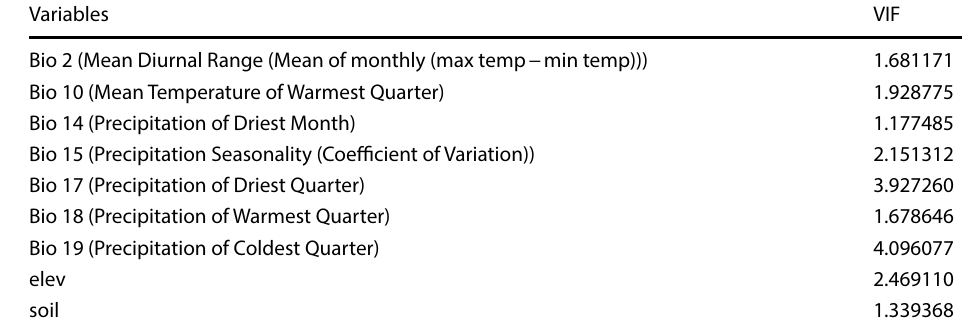
Table 1 Environmental variables used for modelling the potential distribution of Anogeissus leïocarpa (DC.) Guill. & Perr.